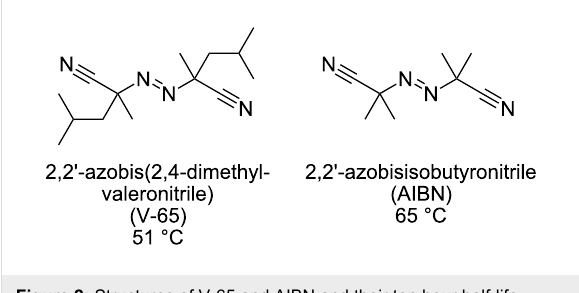
Figure 2: Structures of V-65 and AIBN and their ten hour half-life decomposition